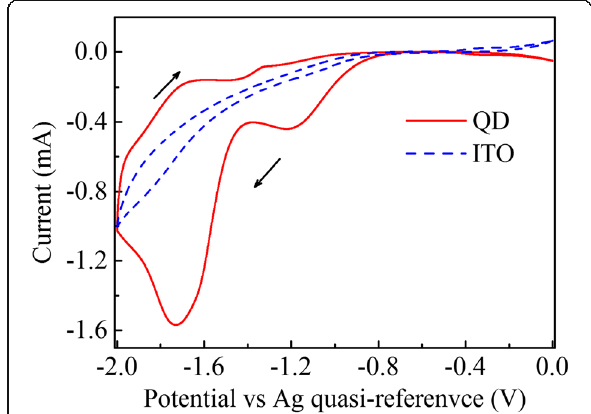
Fig. 1 Cyclic voltammetry of CdSe/ZnS QD film (solid) and ITO (dashed) at 100 mV/s. The peak at − 1.7 V is attributed to the charging of 1S e state, and the peak at − 1.2 V is attributed to the charging of surface trap states. The arrows indicate the scan direction. The Ag quasi-reference is offset by 65 mV versus standard hydrogen electrode (SHE)